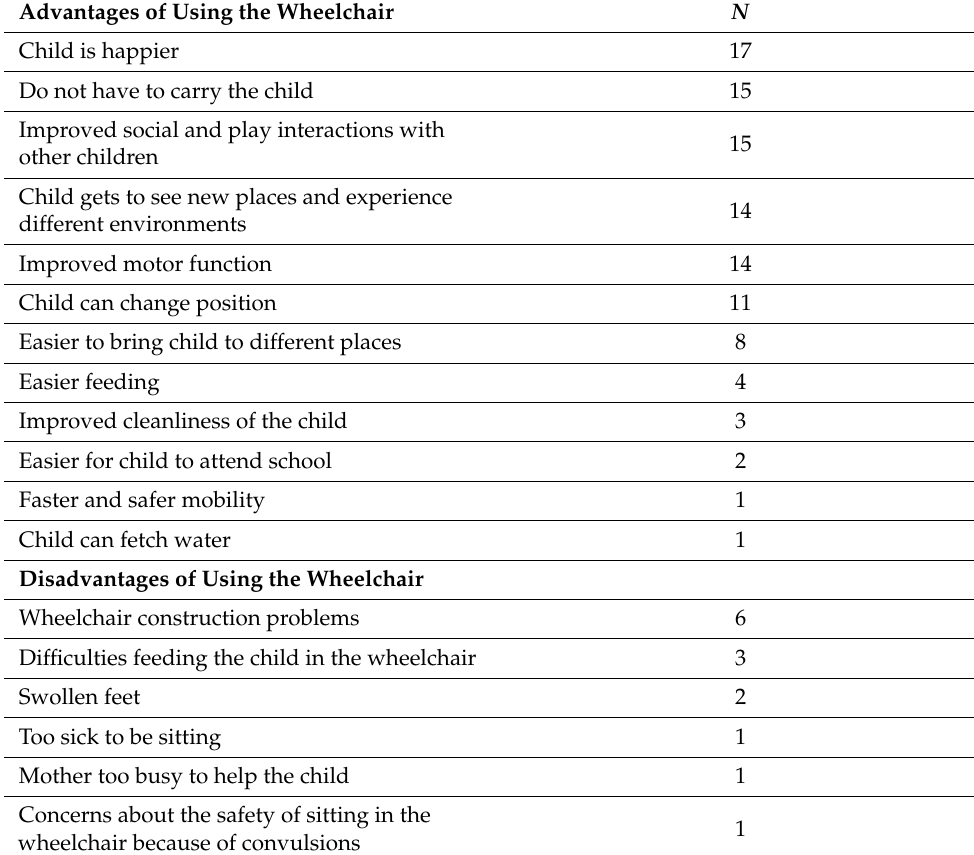
Table 3. Categories of advantages and disadvantage of using the wheelchair as identified by care- givers at the 6–10-month evaluation; each caregiver ( N = 31) could identify several advantages, resulting in more advantages than participants.